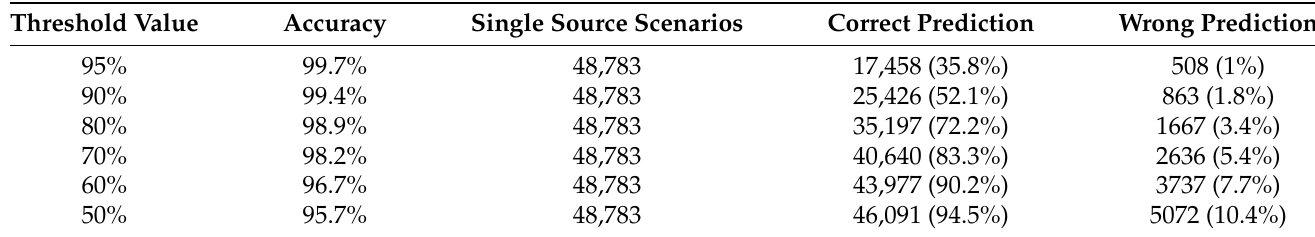
Table 2. Influence of threshold value on model accuracy for Net3 network (180 estimators, maximum depth 80, minimum samples for split 10). Percentage indicates number of predicted simulations based on total number of single source scenarios.